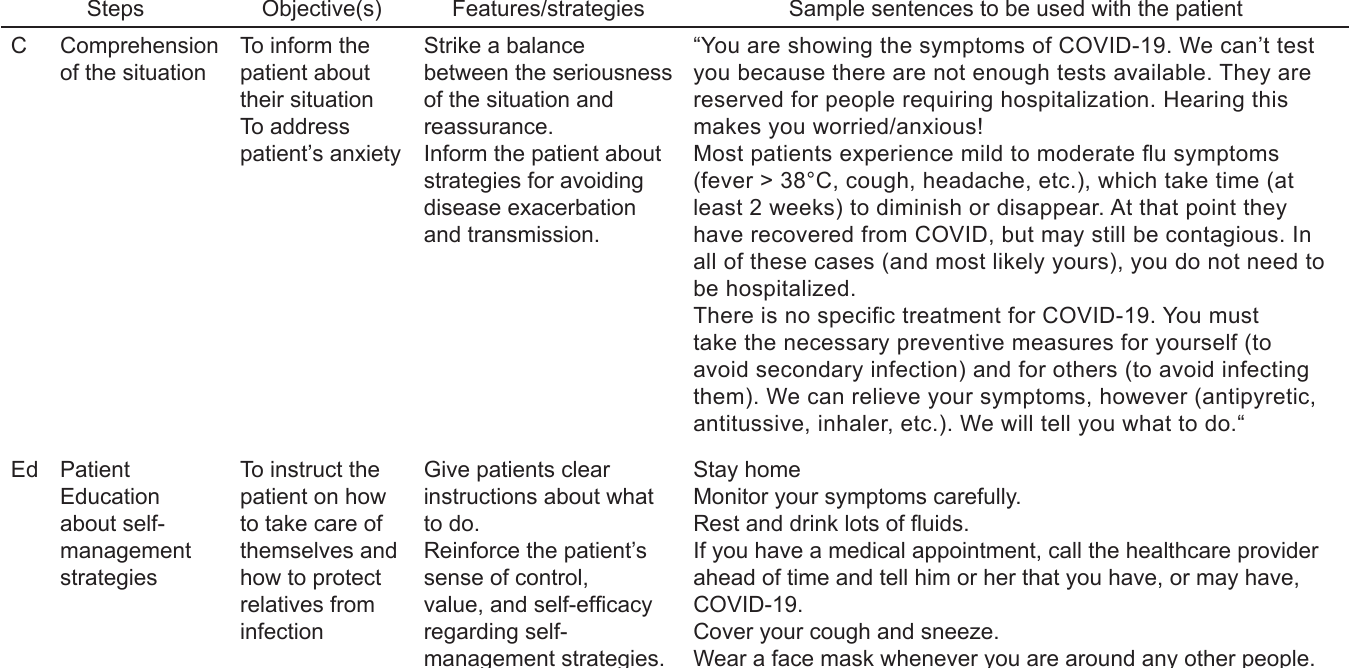
Table 1. CEdRIC strategy: a five-step process to improve education of suspected or confirmed COVID-19 patients who are instructed to self-isolate at